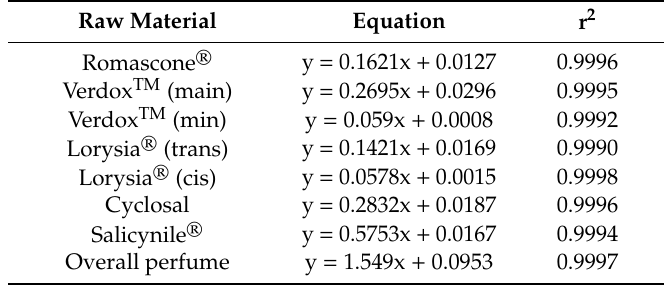
Table 1. Linear regression obtained by Py-GC-MS for each perfume ingredient and the corresponding total